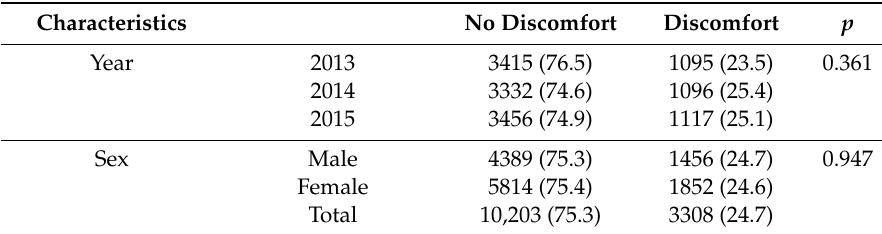
Table 1. General characteristics of study subjects. Unit: N